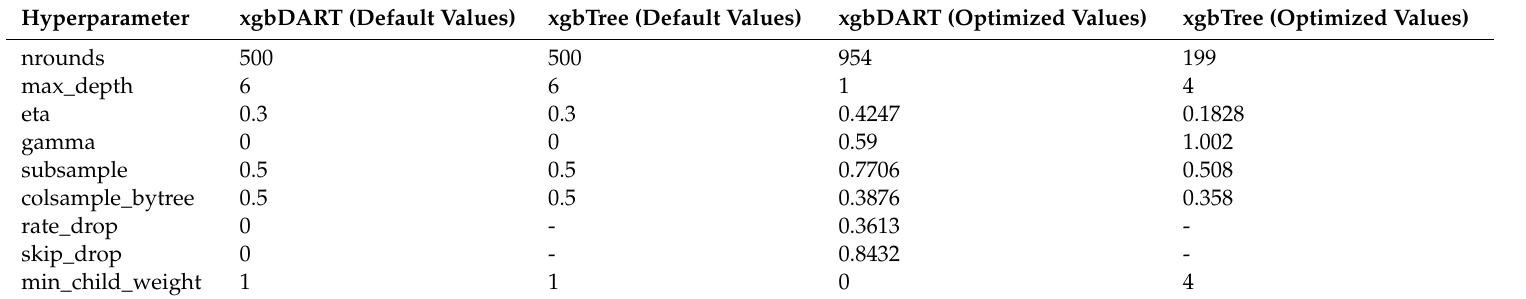
Table 8. The specific hyperparameters of gradient boosting models.